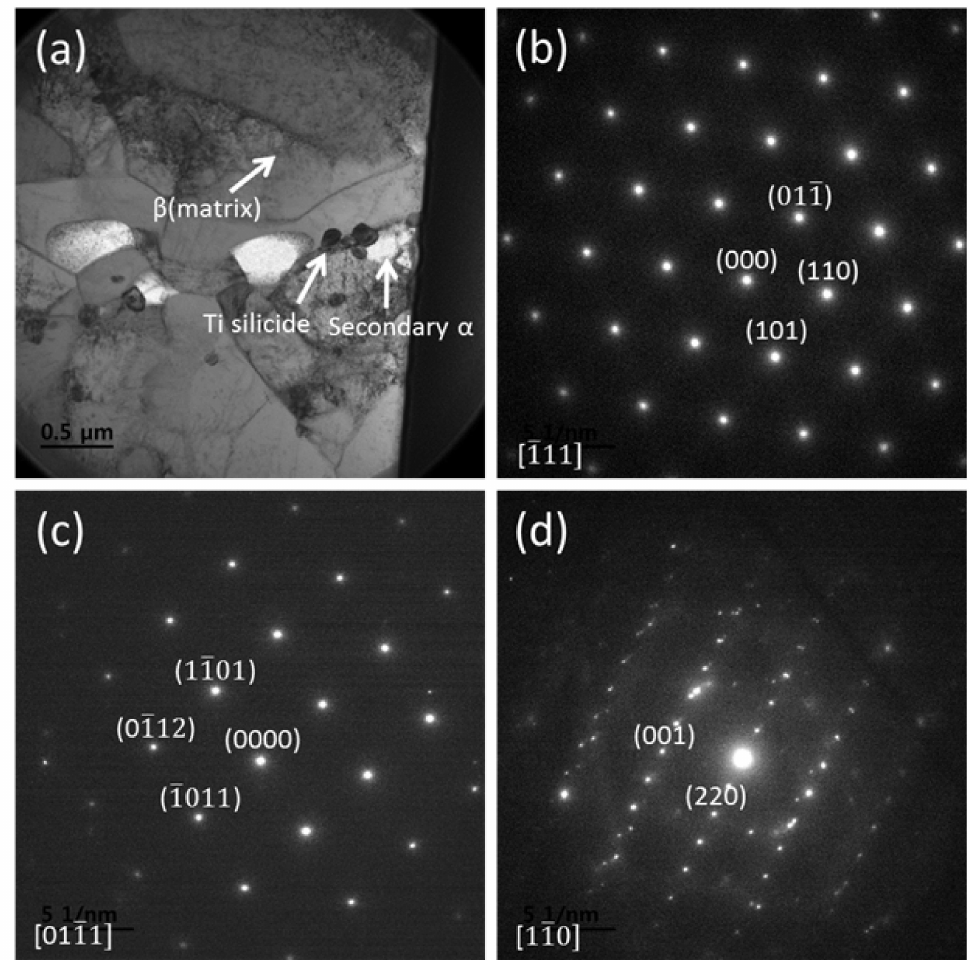
Figure 4. ( a ) TEM microscopy of STA-treated TNZ40 alloy containing 0.2% Si and SAD pattern of ( b ) β -Ti matrix, ( c ) sec- ondary α -Ti, and ( d ) Ti silicide